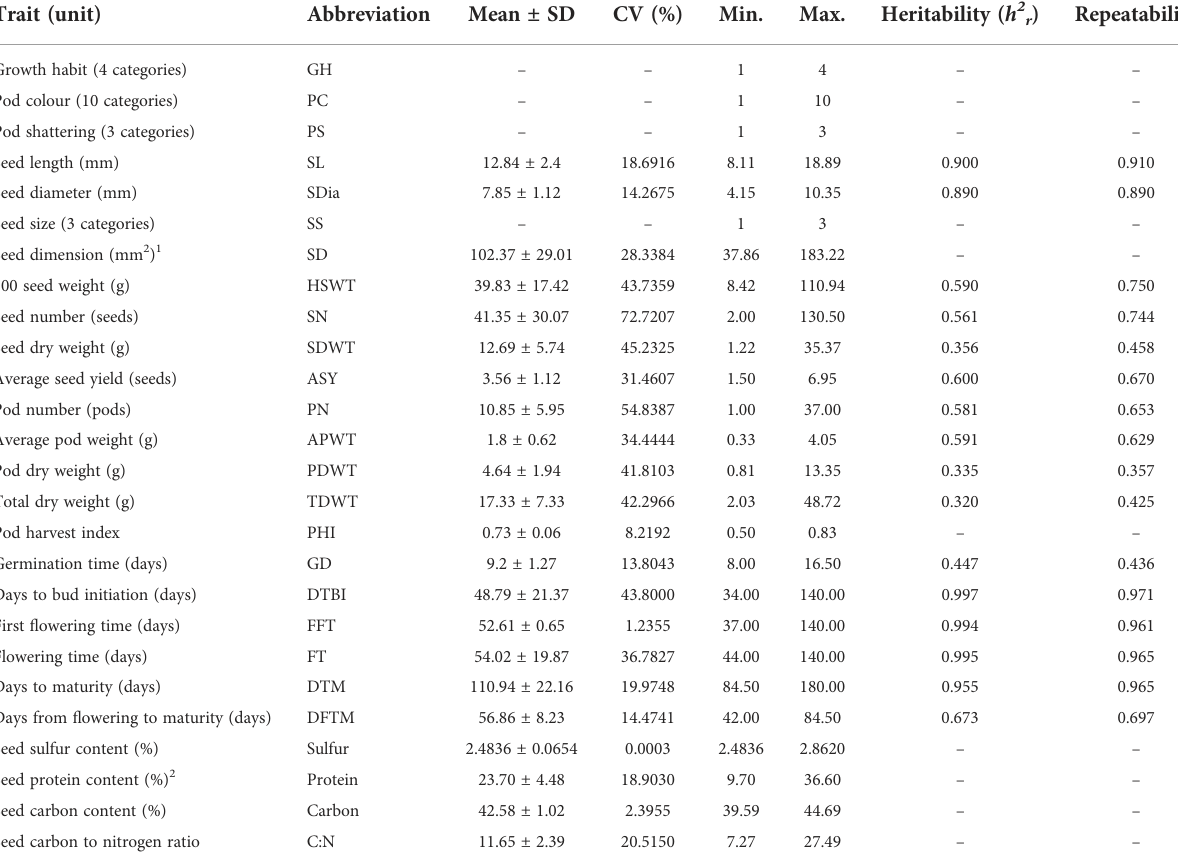
TABLE 1 Summary of phenotypic traits measured for 192 common bean